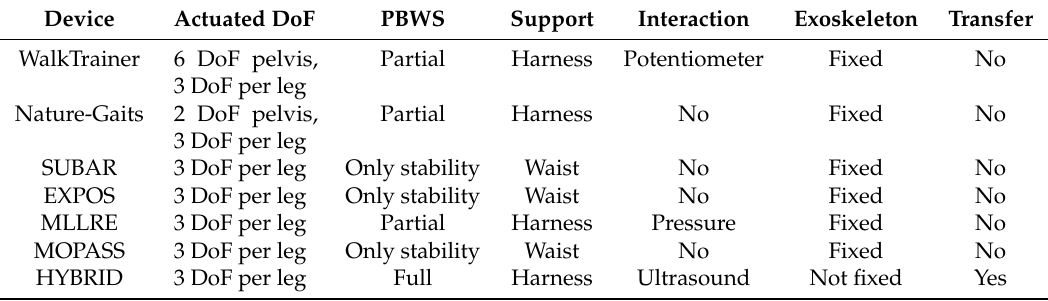
Table 13. Comparison between HYBRID and other gait